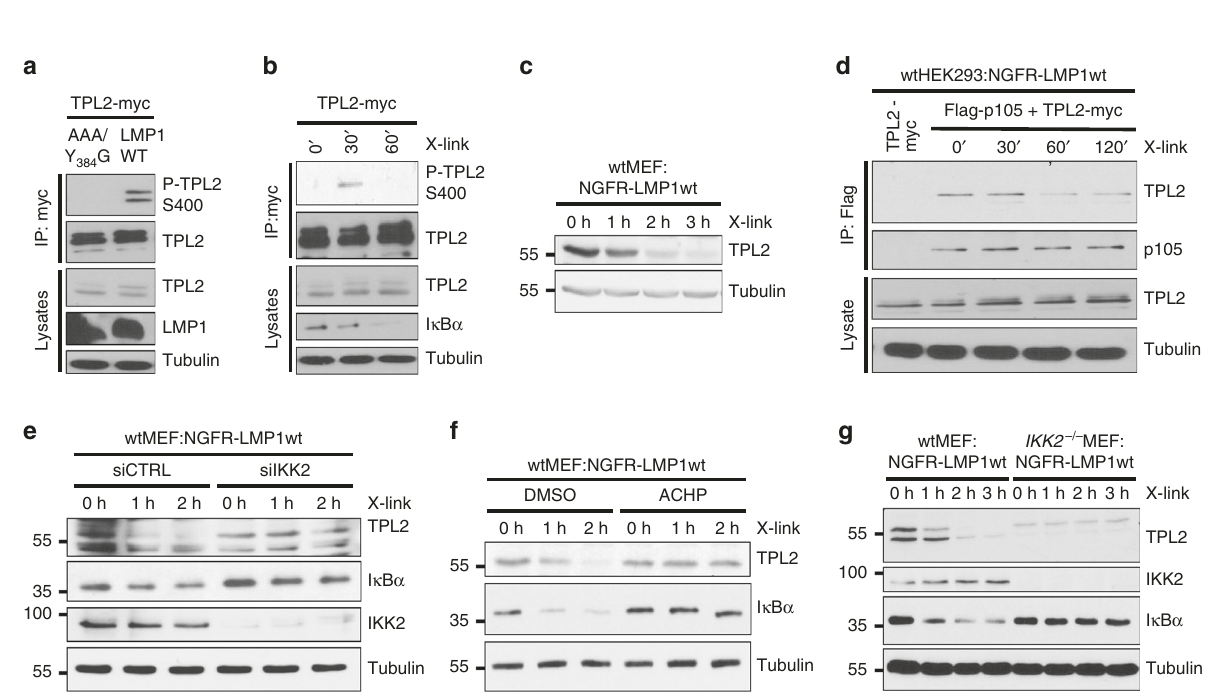
Fig. 4 LMP1 activates TPL2 via IKK2. a , b LMP1 activity induces TPL2 phosphorylation at serine 400. a HEK293 cells were transfected with TPL2-myc together with HA-LMP1 wildtype or inactive AAA/Y384G. Phosphorylation of immunoprecipitated TPL2-myc was detected with the P-TPL2 S400 antibody. b HEK293 cells, which stably express NGFR-LMP1, were transfected with Myc-tagged TPL2. NGFR-LMP1 activity was induced by antibody crosslinking 24 h after transfection. TPL2-myc was immunoprecipitated and TPL2-myc phosphorylation was detected. c LMP1 activity causes TPL2 degradation. Immunoblot analysis of wtMEF:NGFR-LMP1wt cells induced by antibody crosslinking. d TPL2 is released from its complex with p105 after LMP1 induction. HEK293:NGFR-LMP1wt cells were transfected with Flag-p105 and TPL2-myc vectors. After 24 h, NGFR-LMP1 was induced for the indicated times and Flag-p105 was precipitated via its Flag-tag. Interaction of TPL2 and p105 was analysed using the indicated antibodies. e The knockdown of IKK2 blocks LMP1-induced TPL2 degradation. Cells were transfected twice with IKK2 siRNA (siIKK2) or non-targeting control siRNA (siCTRL). After 24 h, NGFR-LMP1 activity was induced and TPL2, I κ B α , and IKK2 levels were analysed. f LMP1-induced TPL2 degradation depends on IKK activity. NGFR-LMP1 was induced in MEFs by antibody crosslinking in the presence of DMSO or 5 µ M ACHP. g LMP1 fails to induce TPL2 degradation in the absence of IKK2. NGFR-LMP1 activity was induced in wildtype and IKK2 − / − MEFs, and cellular protein levels were analysed. b This experiment con fi rms the results of a